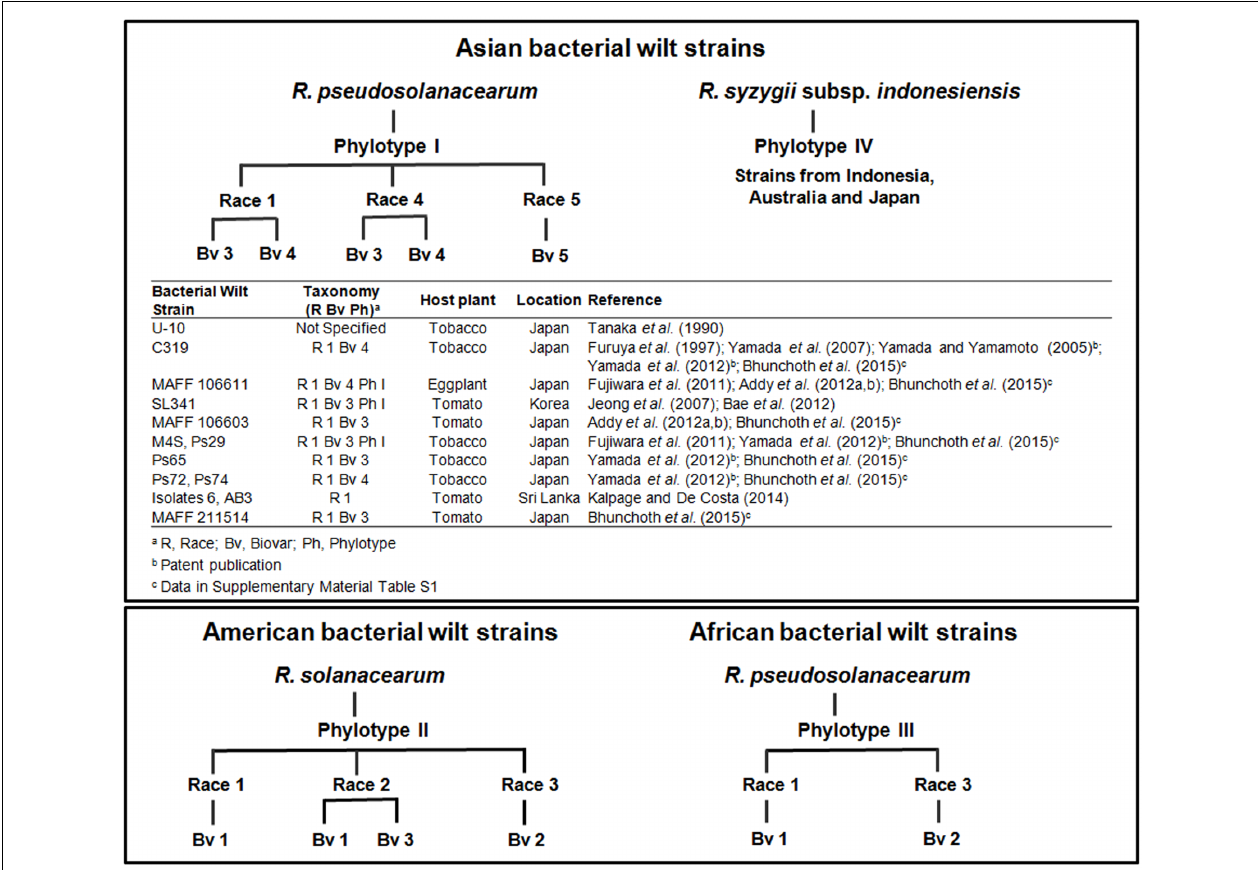
FIGURE 1 | Bacterial wilt strains used to test the biocontrol potential of the bacteriophages in planta . Correspondence among the geographical origin of bacterial wilt strains, the species Ralstonia pseudosolanacearum , R. syzygii subsp. indonesiensis , and present R. solanacearum (Safni et al., 2014) (former “ R. solanacearum species complex” according to Fegan and Prior, 2005), and previous infraspecific classifications of the species complex in four phylotypes, five races, and five biovars, according to molecular characteristics (Fegan and Prior, 2005), host range (Buddenhagen and Kelman, 1964; Hayward, 1991) and biochemical properties (Hayward, 1964, 1991), respectively. To date, all bacteriophage-based biocontrol assays were performed against Asian bacterial wilt strains, presently not classified as R. solanacearum .